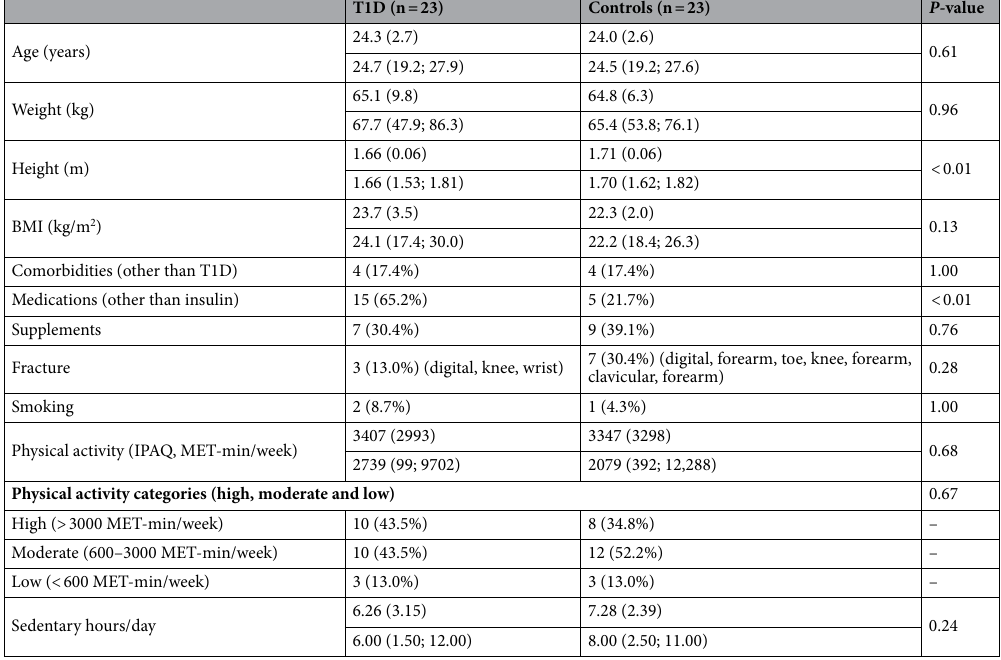
Table 1. Clinical data of subjects with T1D and matched healthy controls. For categorical variables n (%) is presented. For continuous variables, mean (SD)/median (minimum; maximum) are